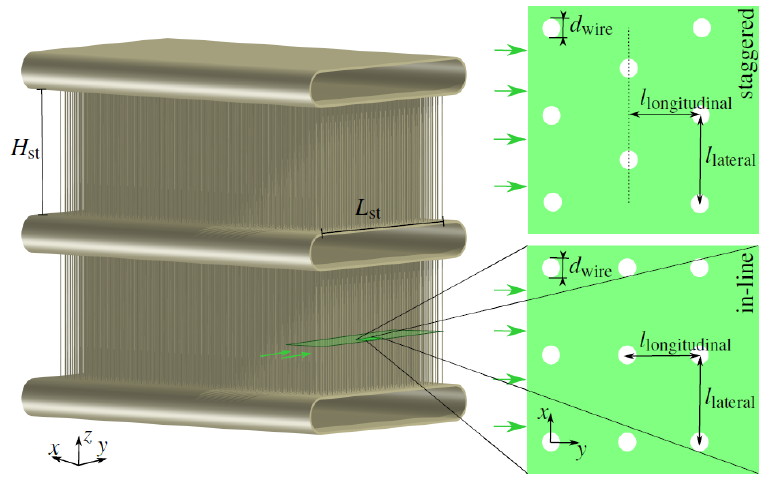
Figure A3. Definition of geometrical parameters for a wire structure pin fin heat exchanger